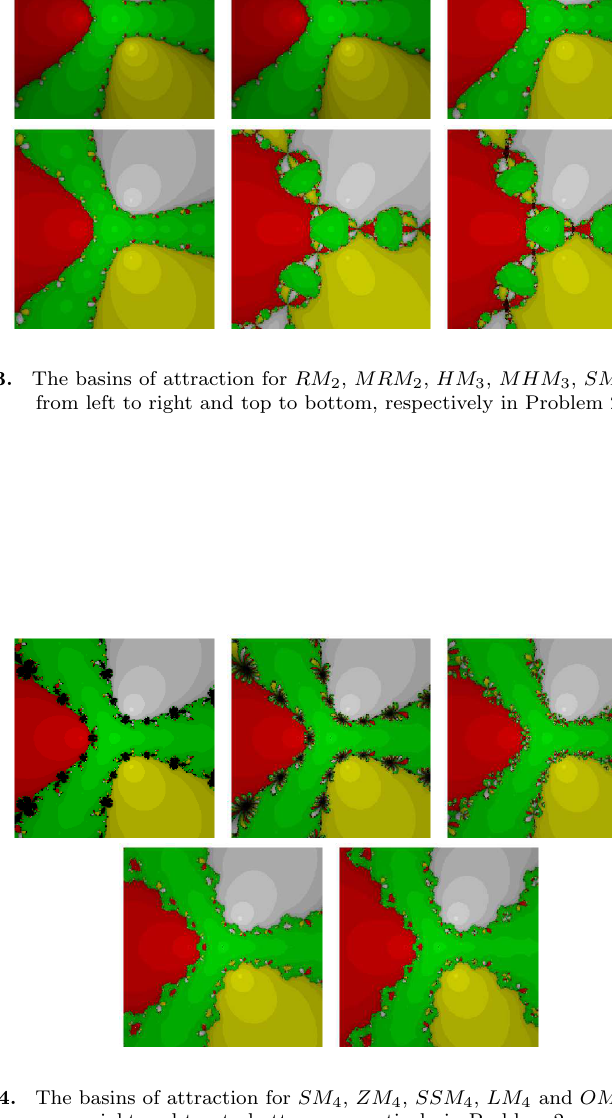
Math. Model. Anal., 24(3):422–444,